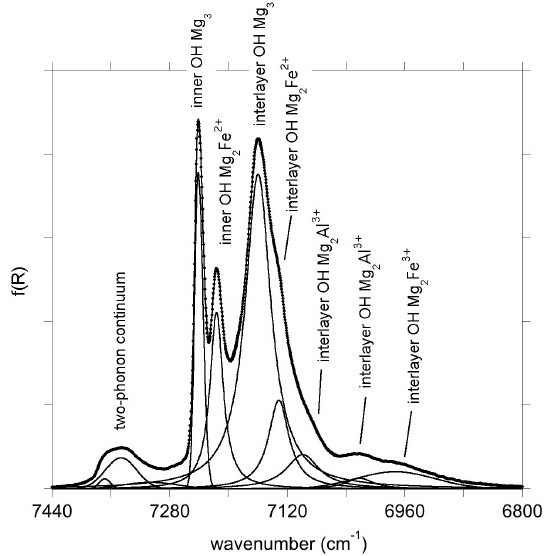
Figure 8. Interpretation of the OH stretching overtone spectrum of Monte Fico